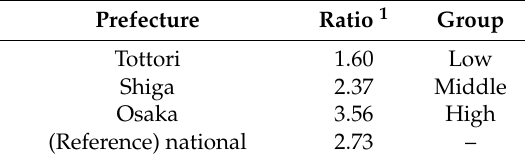
Table 1. The ratio of active job openings to applicants in long-term care in March